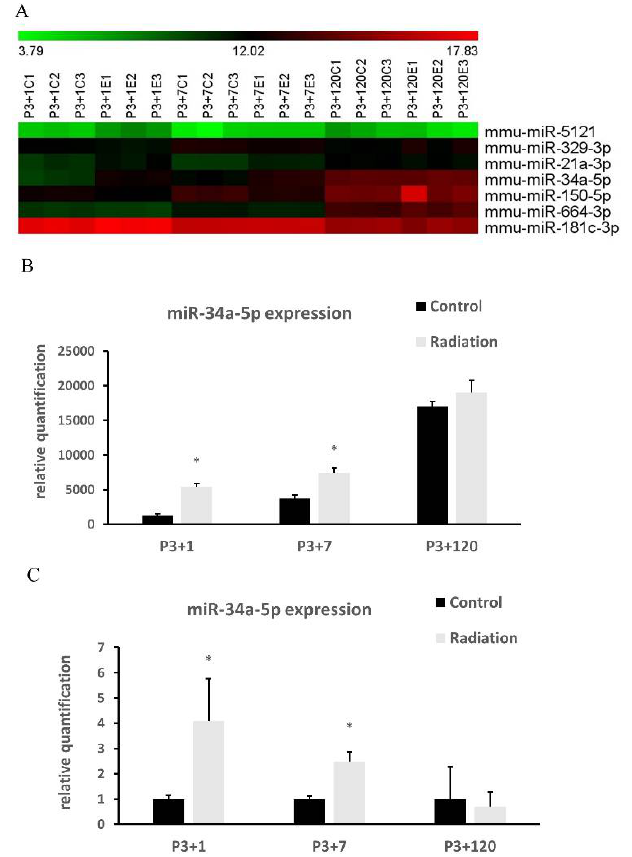
Figure 5. A heatmap displays seven differentially expressed miRNAs identified by systematic deep microRNA sequencing (miRSeq) among mice at 1, 7, 120 day(s) after irradiation at P3 and the respective control ( A ). The color bar from left to right represents the expression levels from low to high, and the number indicates the base-2 logarithm of miR expression. Among these miRNAs, the expression of miR-34a-5p is summarized in ( B ). Real-Time Quantitative Reverse Transcription PCR (qRT-PCR) validates the increased expression of miR-34a-5p at 1 and 7 day(s) after radiation exposure ( C ). Data are expressed as mean ± SEM ( n = 3). * p < 0.05 vs respective control.